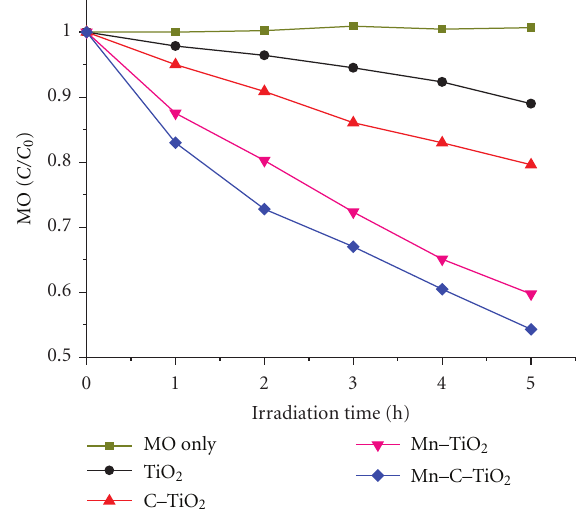
Figure 8: Photocatalytic degradation of MO with as-prepared